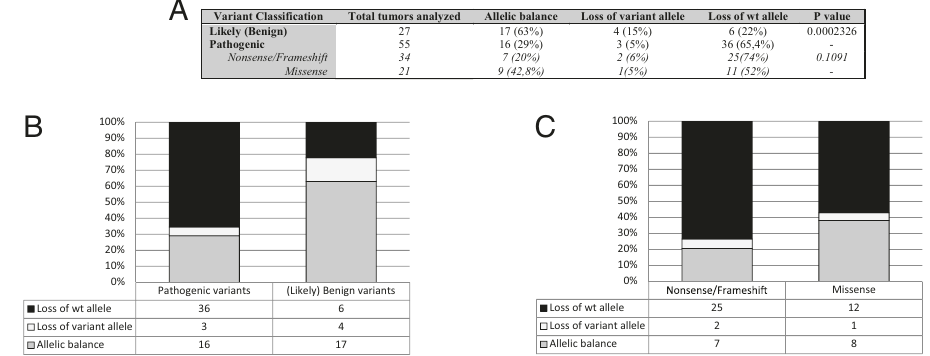
Fig. 2 Proportion of breast/ovarian samples presenting loss of wt allele among pathogenic and (likely) benign variants considering variant effect at the protein level. A Results obtained according to the class of the variant. For the pathogenic variants, there are also results according to the type of variant: missense or Nonsense/Frameshift; B Histogram of the results according to the class; C Histogram representation of the results for the pathogenic variants according to the type of